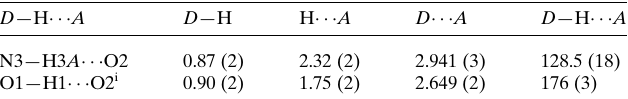
Table 1 Hydrogen-bond geometry (A˚ , (cid:2) ) for (I).